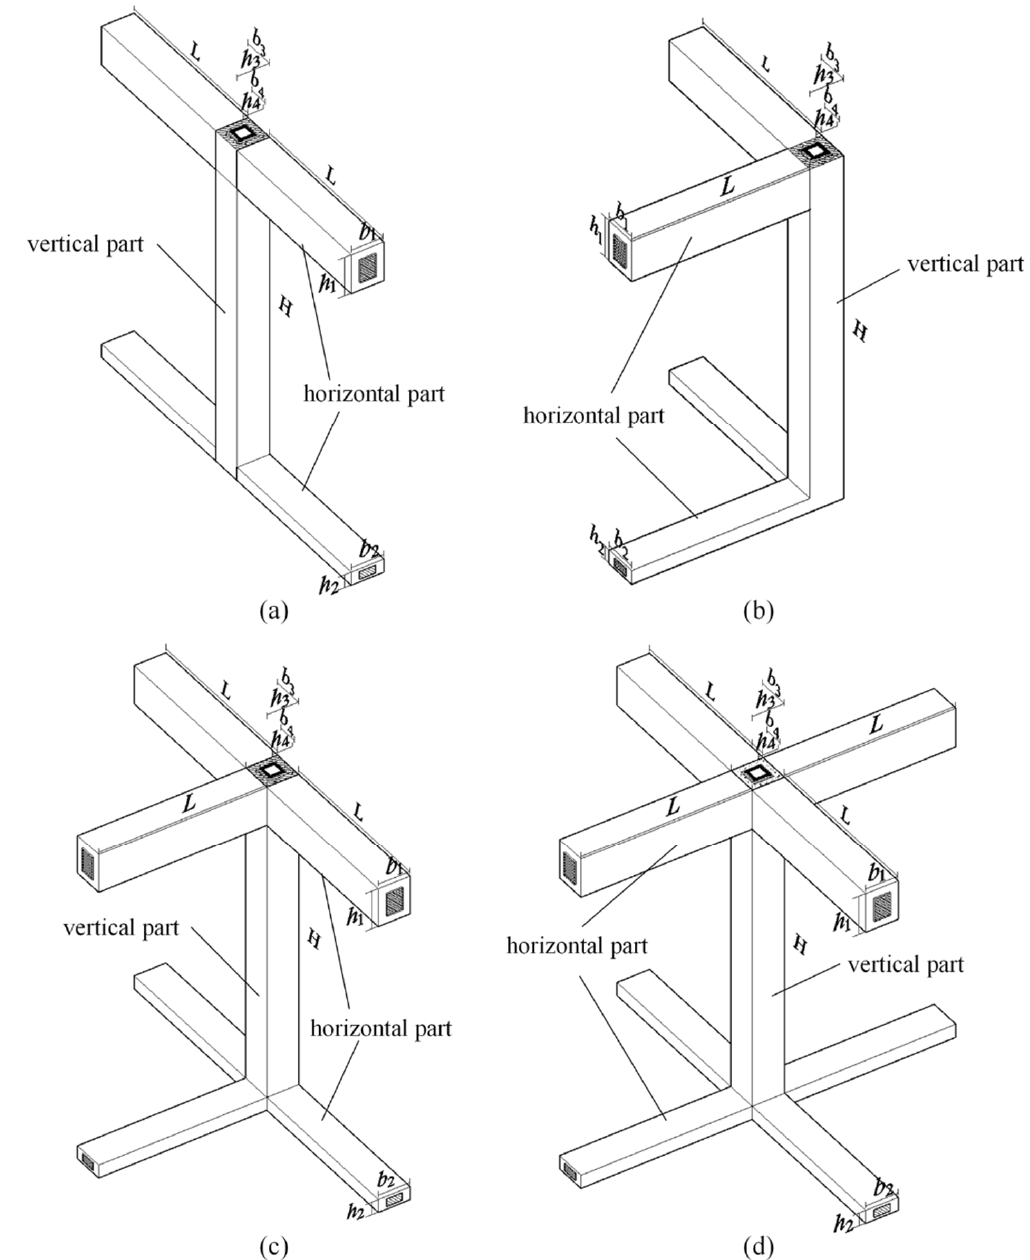
Figure 2. Schematic diagram of four types of prefabricated cantilever components: ( a ) standard H-shaped component, ( b ) corner L-shaped component, ( c ) T-shaped component, and ( d ) cross-shaped component. Each basic prefabricated cantilever component includes the upper horizontal part (solid rectangle section denoted as b 1 × h 1 and the cantilever length is denoted as L ), the lower horizontal parts (solid rectangle section denoted as b 2 × h 2 and the cantilever length is also denoted as L ), and the vertical part (hollow rectangle section, the outer size is denoted as b 3 × h 3 , the inner size is denoted as b 4 × h 4 , and the height is denoted as H ). Steel plate is embedded at the outer end of the horizontal part as a connector (Figure